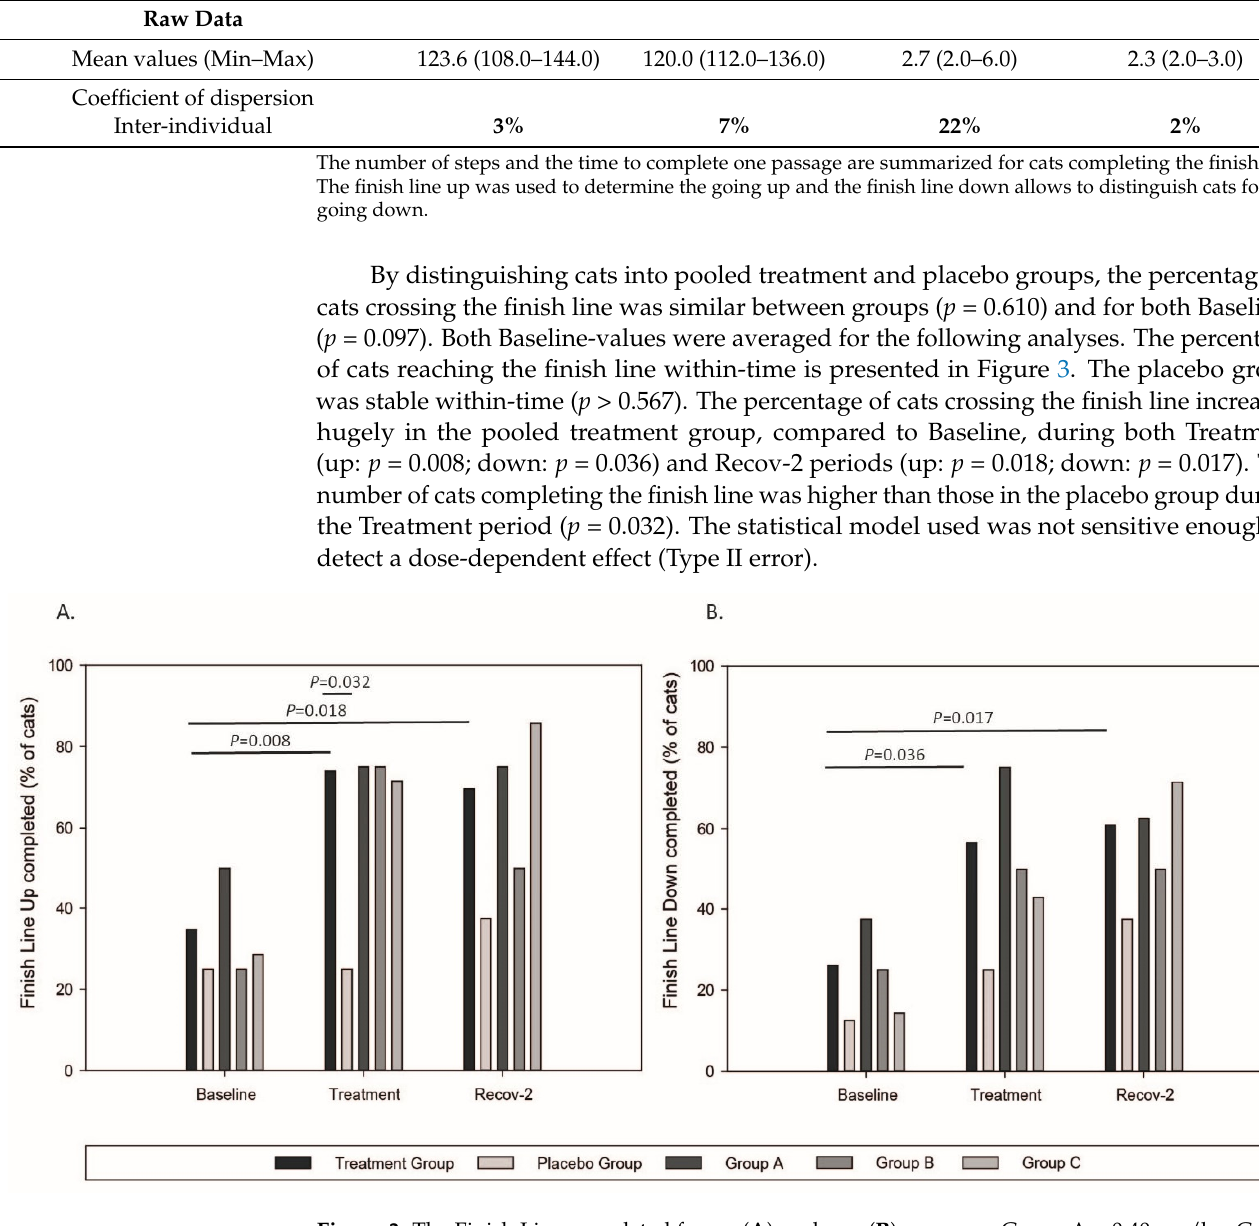
Figure 3. The Finish Line completed for up ( A ) or down ( B ) passages. Group A = 0.40 mg/kg, Group B = 0.25 mg/kg, Group C = 0.15 mg/kg of Firocoxib. Recov ‐ 2 = second recovery period.